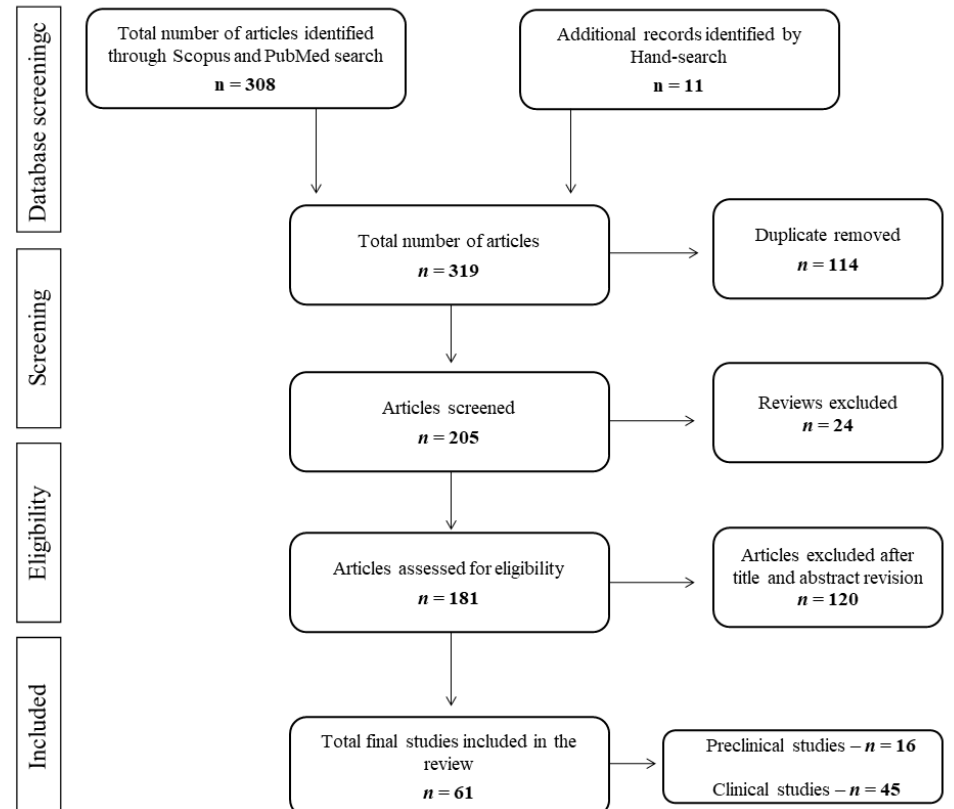
Figure 1. Flow Diagram. From top to bottom, the total number of outputs from Scopus and PubMed searches ( n = 464). Selection based on year, language ( n = 308) and exclusion of duplicates ( n = 194), the total number of studies that successfully passed the selection checklist ( n = 50), and the total number of accepted studies after parallel searching ( n = 61).